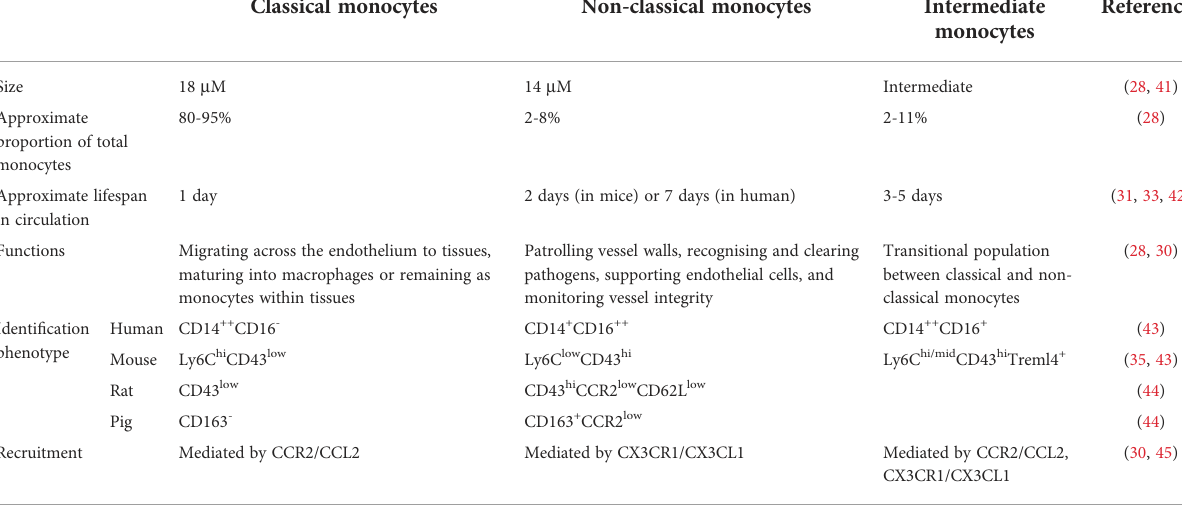
TABLE 1 Speci fi c immune markers and functions of monocyte